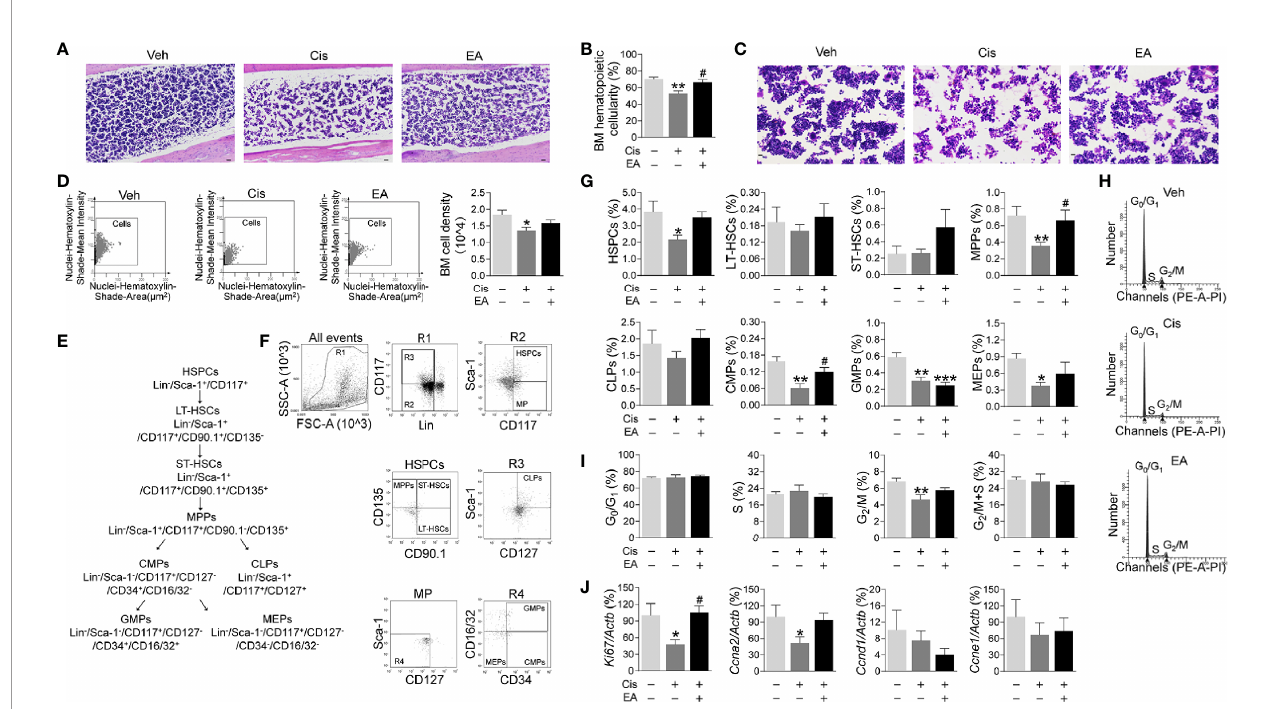
FIGURE 2 | Electroacupuncture preserved hematopoiesis in mice with cisplatin chemotherapy. (A) Representative H&E staining of tibia BM from mice with control (Veh), cisplatin alone (Cis; 3 mg/kg), or with electroacupuncture (EA) treatment (scale bar=20.0 m m) and (B) Histogram representation of BM hematopoietic cellularity of H&E staining analyzed by Image-Pro Plus 6.0 software ( n= 4 per group). (C) Representative H&E staining of tibia BM from mice with Veh, cisplatin alone or with EA treatment at high con fi guration (scale bar=10.0 m m). (D) Representative HistoFAXS Tissue Analysis of BM cell nuclei hematoxylin-shade-mean intensity, and quantitative analysis of BM cell density ( n =4 per group). (E) Flowchart of hematopoiesis and hematopoietic cells markers. (F) Representative fl ow cytometry analyses and (G) quanti fi cation of hematopoietic BM cell subpopulations (Positive cells events (%) = (the events in target gate/the total cell) × 100) ( n =6 per group). (H) Representative PI nuclear staining fl ow cytometry analyses in BM cell cycle (G 0 /G 1 , S, G 2 /M phases) and (I) Quanti fi cation of PI nuclear staining of BM cells in G 0 /G 1 , S, G 2 /M phases by ModFit 3.1 software ( n =6 per group). (J) Expression of cell cycle related genes in BM cells ( Ki67 : Veh, n =7; Cis, n =5; EA, n =7. Ccna2 : n =7 per group. Ccnd1 : Veh, n =5; Cis, n =4; EA, n =6. Ccne1 : Veh, n =6; Cis, n =4; EA, n =5). Data are mean ± SEM, * P < 0.05, ** P < 0.01, *** P < 0.001 vs Veh; # P < 0.05 vs